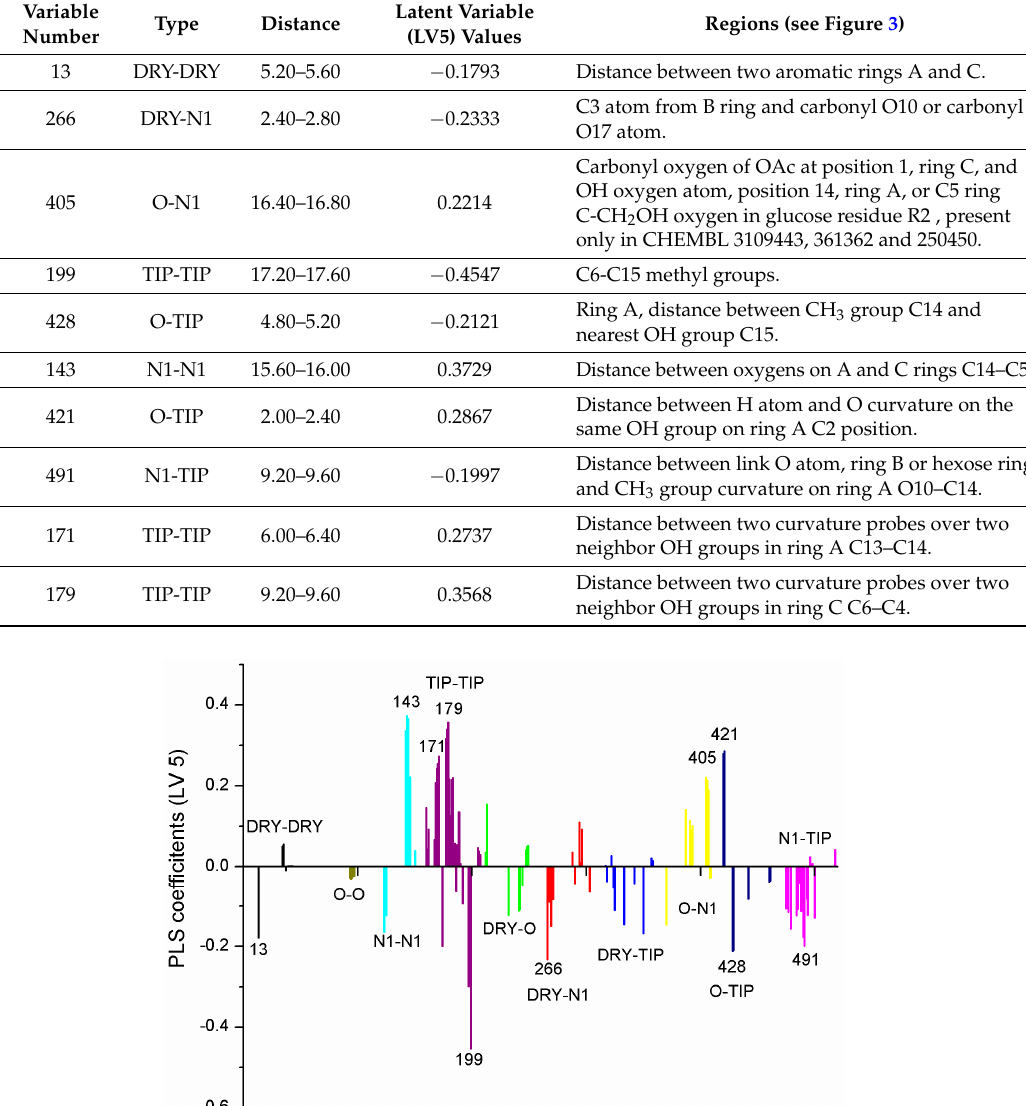
Table 1. Ten most significant PLS variables for Leishmania arginase inhibitors’ QSAR model.